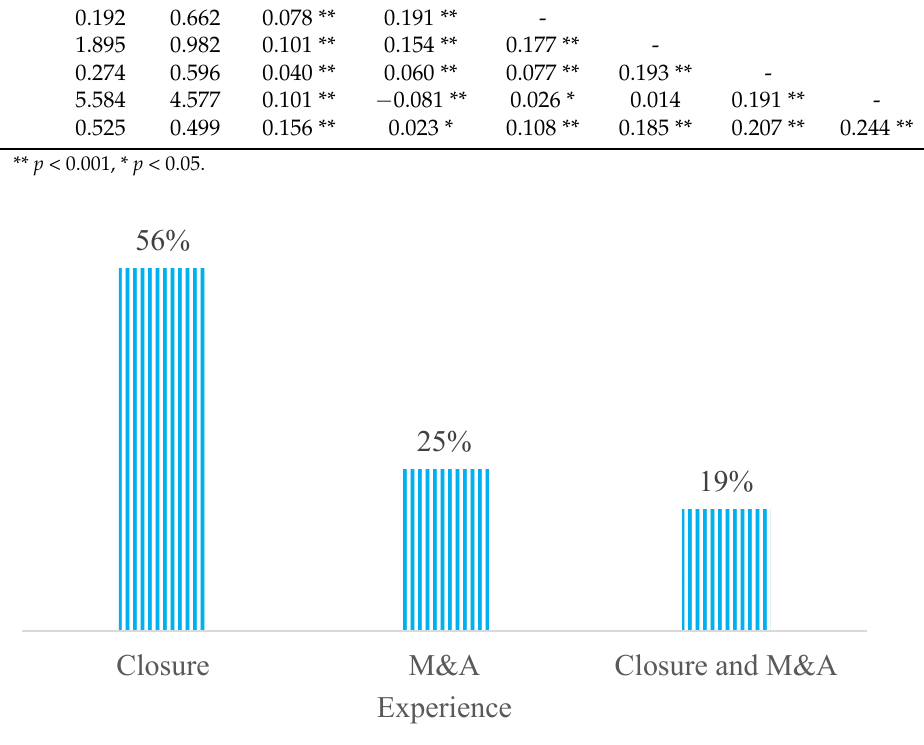
Figure 1. The share of funded start-ups of experienced entrepreneurs by entrepreneurs’ type of experience.